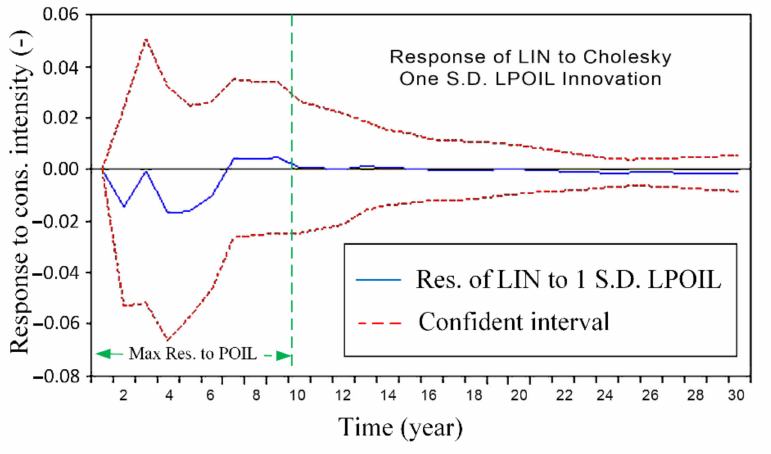
Figure 4. The predicted impact of an oil price impulse on the rate of a standard deviation due to the energy consumption intensity, between